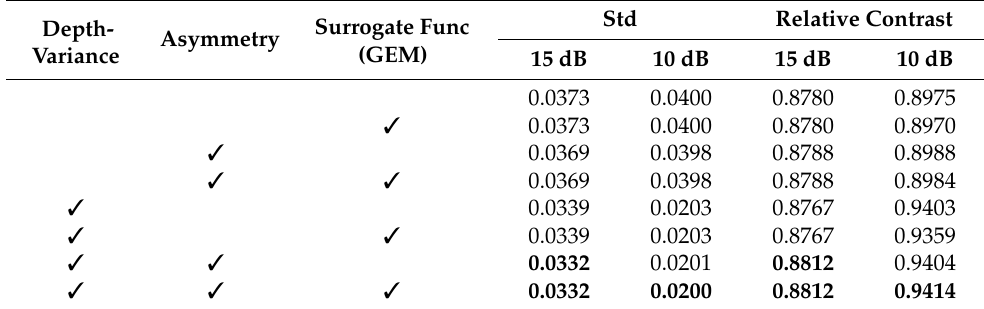
Table 2. Standard deviation of peaks and relative contrast.